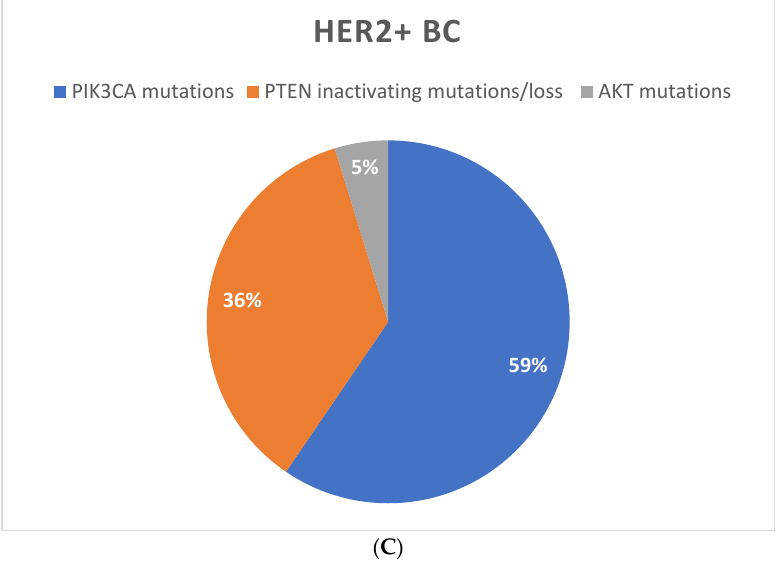
Figure 2. Frequency of PI3K/AKT/mTOR mutations in different breast cancer subtypes: ( A ) HR positive HER2 negative BC, ( B ) TNBC and ( C ) HER2 positive BC, respectively.